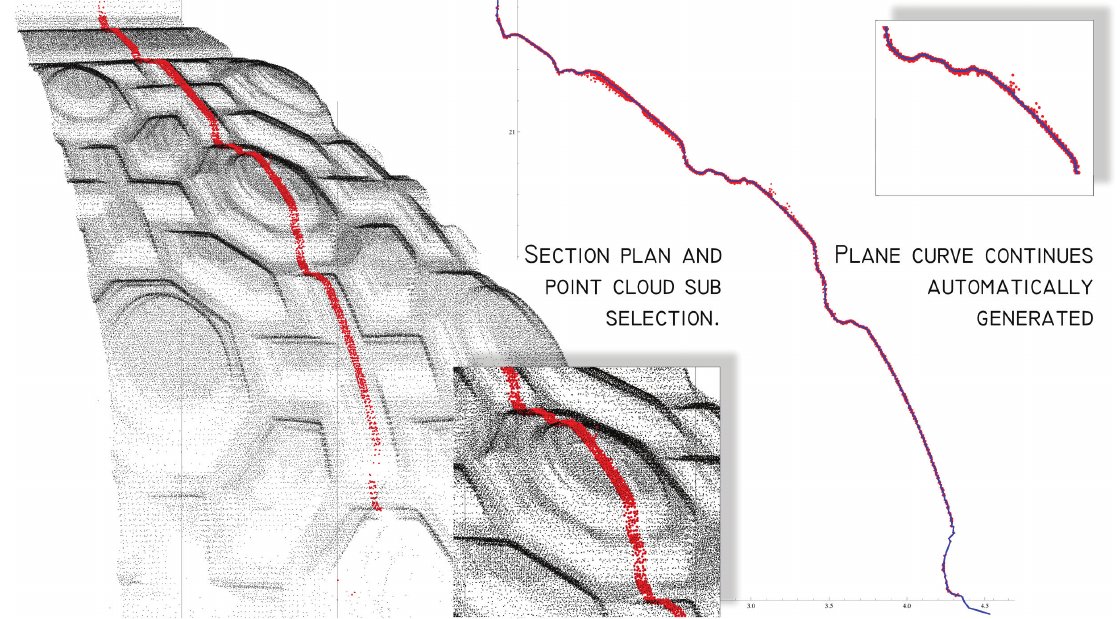
Figure 7. Portion of range based model (section plan and point cloud sub